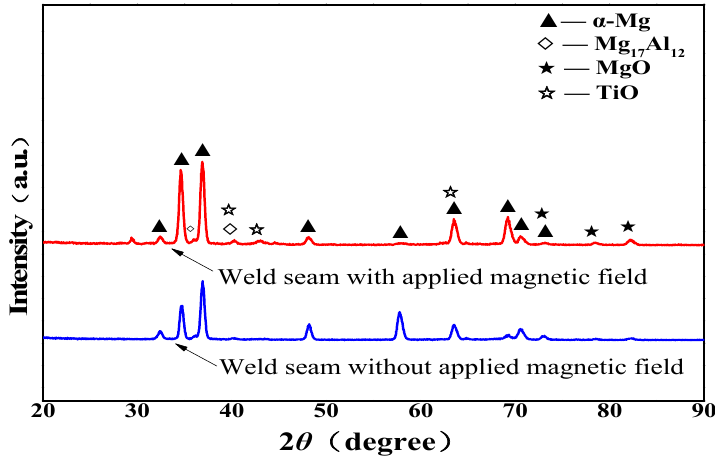
Figure 5. XRD results with and without magnetic field.